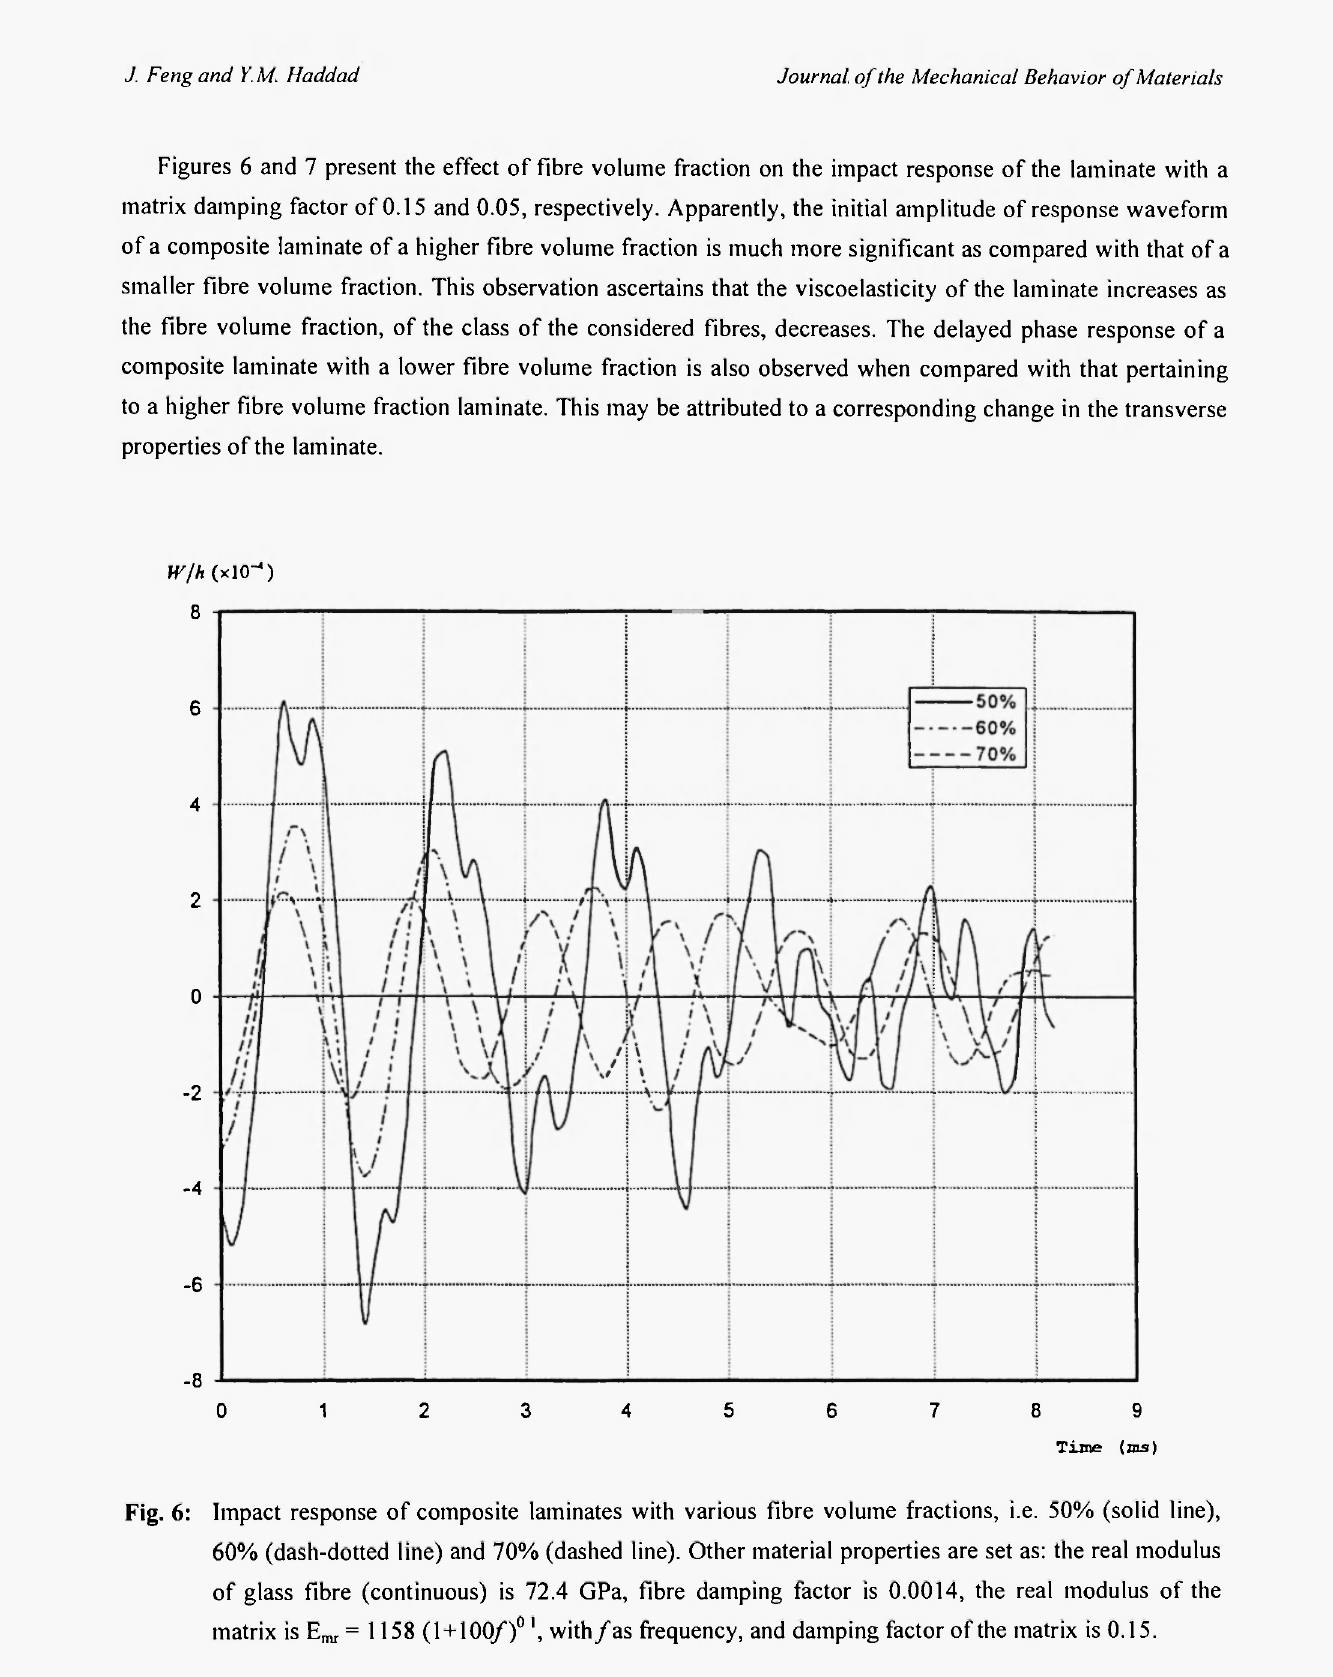
Fig. 6: Impact response of composite laminates with various fibre volume fractions, i.e. 50% (solid line), 60% (dash-dotted line) and 70% (dashed line). Other material properties are set as: the real modulus of glass fibre (continuous) is 72.4 GPa, fibre damping factor is 0.0014, the real modulus of the matrix is E„ = 1158 (1 + 100/)°', with / as frequency, and damping factor of the matrix is 0.15.